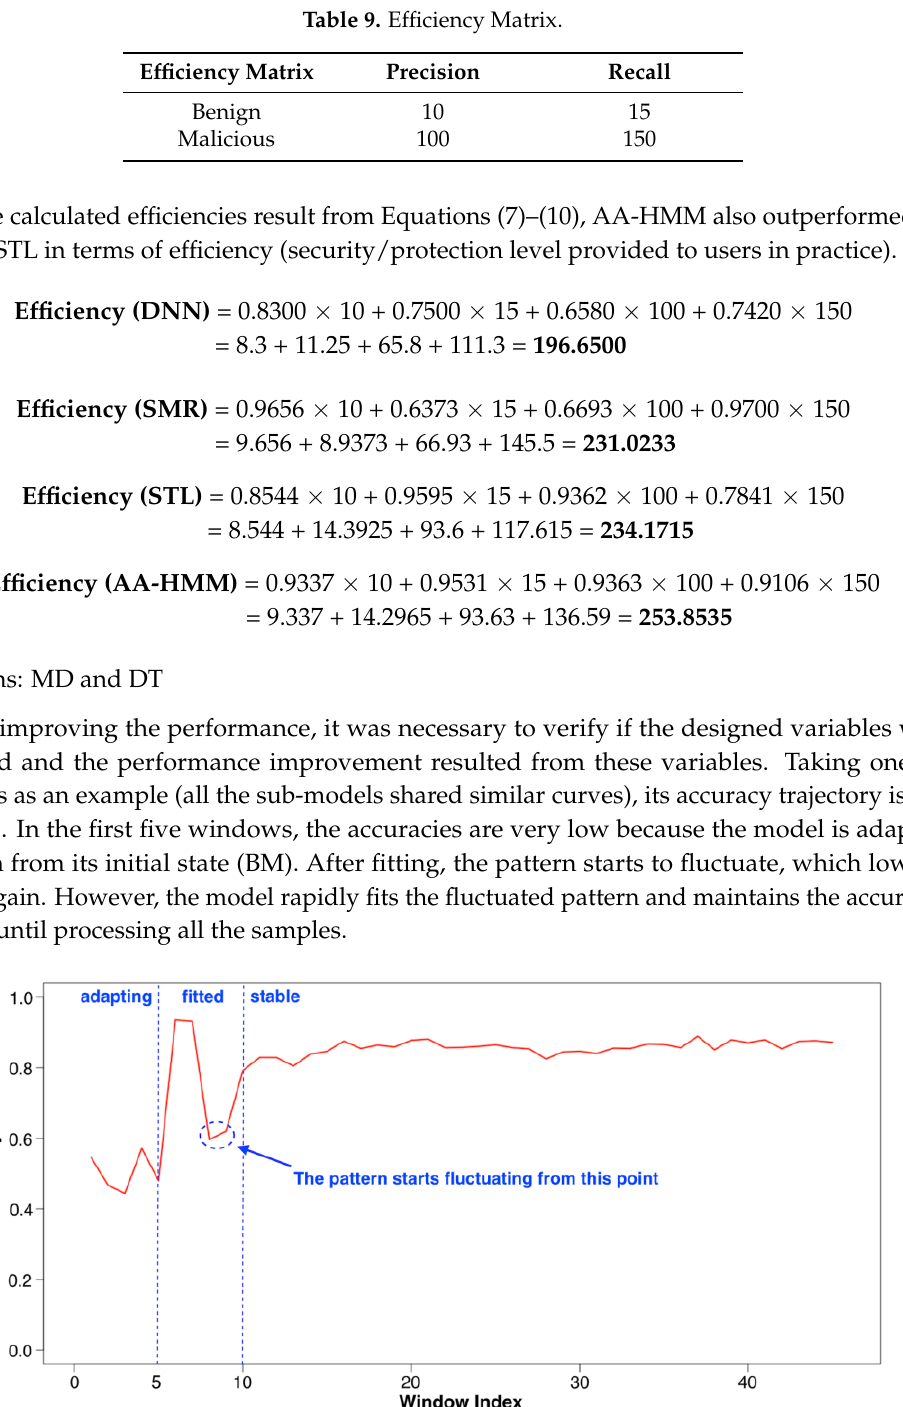
Figure 9: the accuracy increases as the |MD| and |DT| gradually approach zero, which indicates that the model successfully fitted the dynamic patterns and reached a local optimal state. In conclusion, MD and DT are sound metrics and effective adaptive mechanisms for